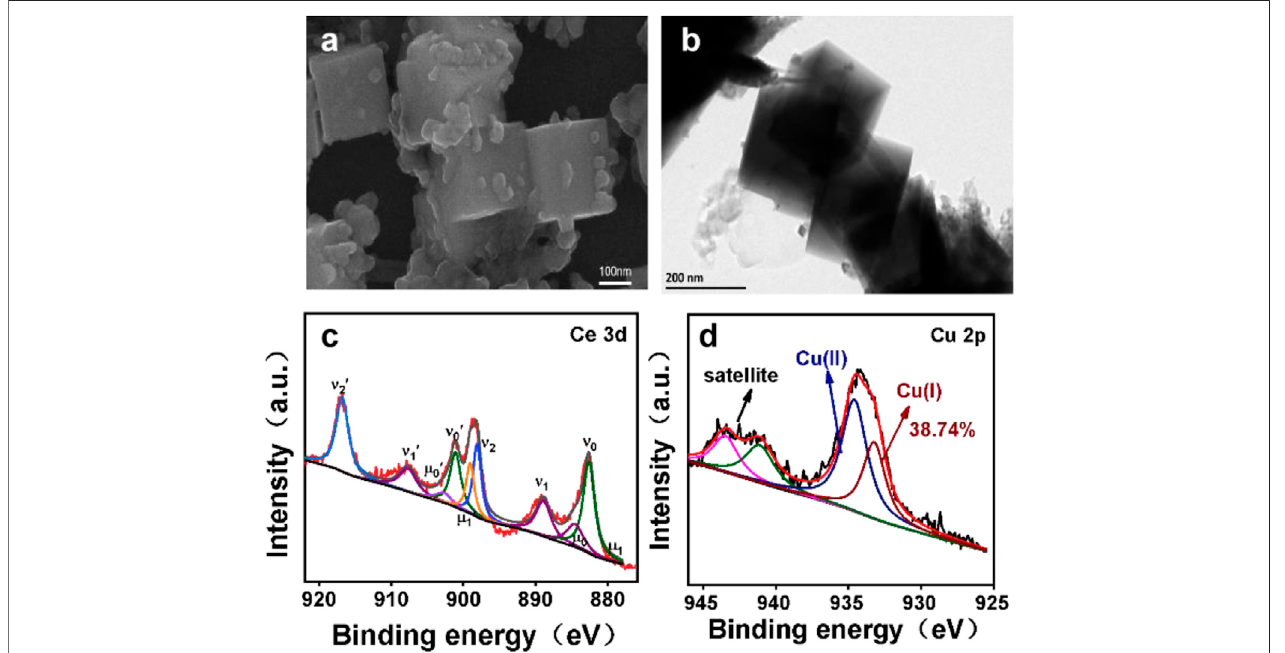
FIGURE5| (A) SEM images ofCuO/CeO